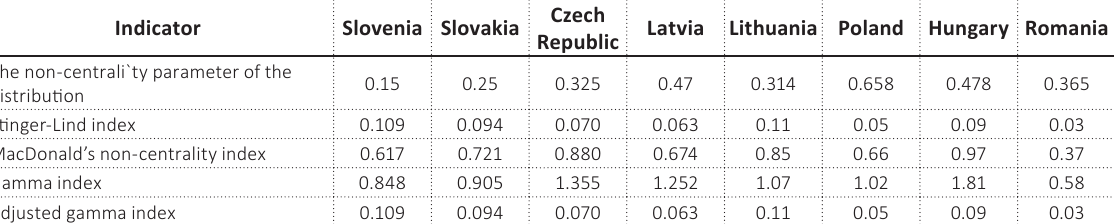
Table 4. The results of the calculation of non-centrality indices